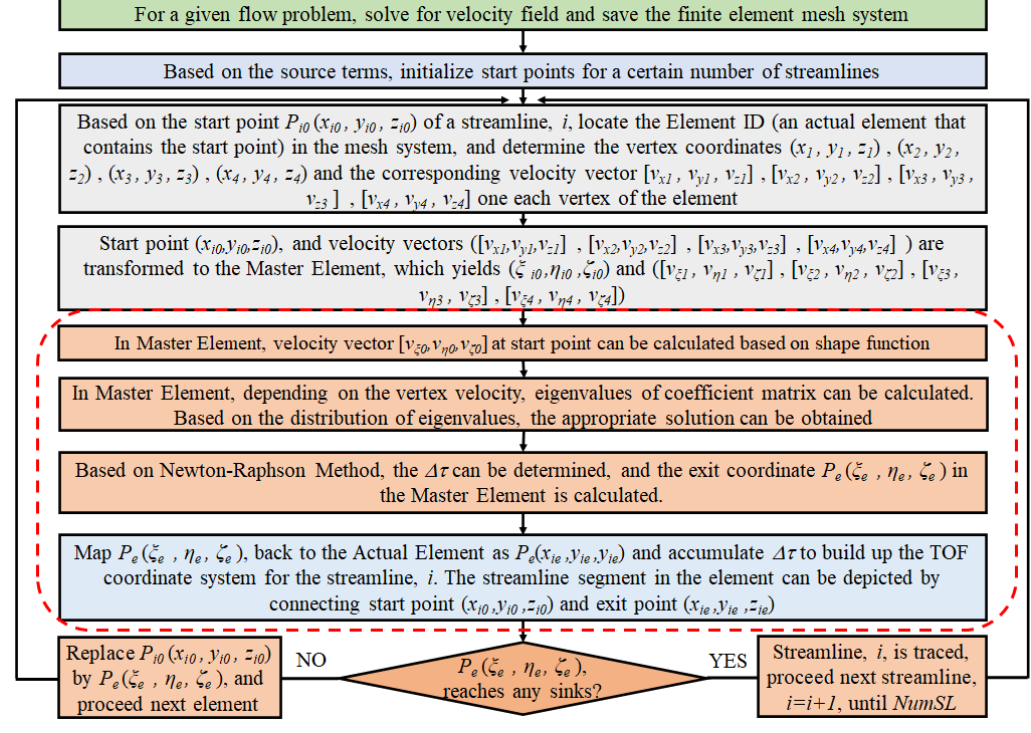
Figure 2. The flowchart of tracing a streamline over the tetrahedron grid system created by Finite Element Method (FEM).